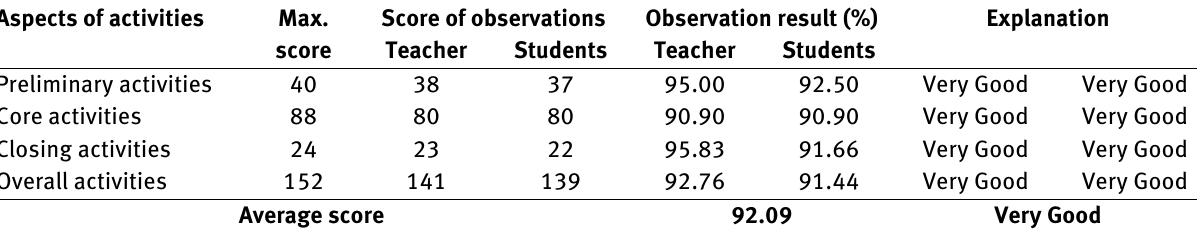
Table 4: Percentage of observation results for experiential learning